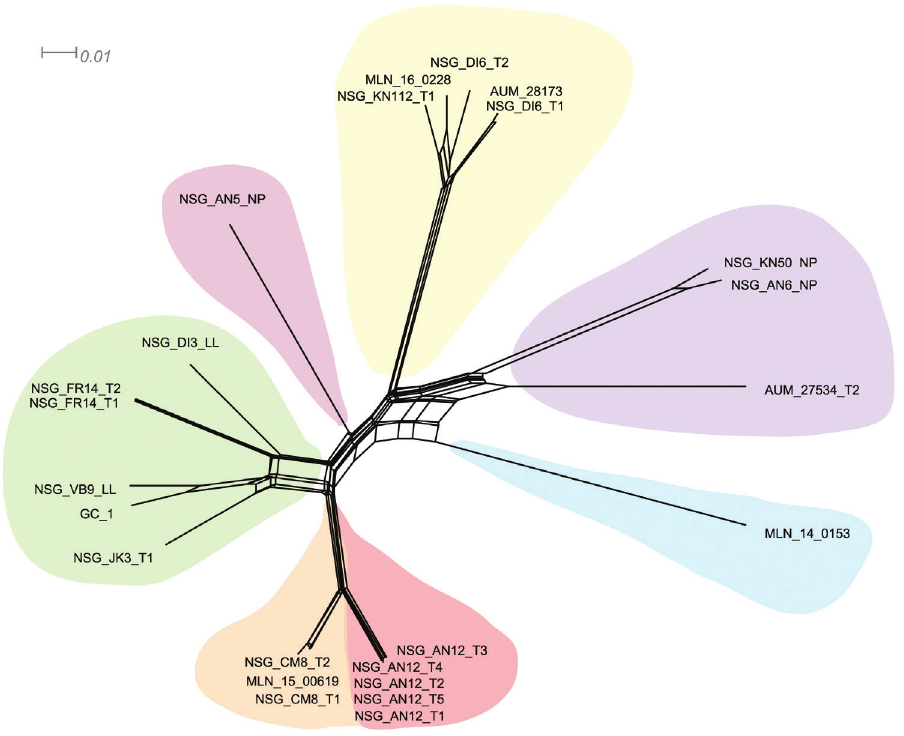
Figure 3. Haplotype network generated using the NeighborNet network method with uncorrected p- distances with the CO1 dataset. Species delimitation results are depicted using major color groups for the mPTP results, and subcolor groups for the ABGD Table 2. Summary statistics generated for all four genes assessed ( mtDNA : CO1, 16S; nDNA : 28S, H3).